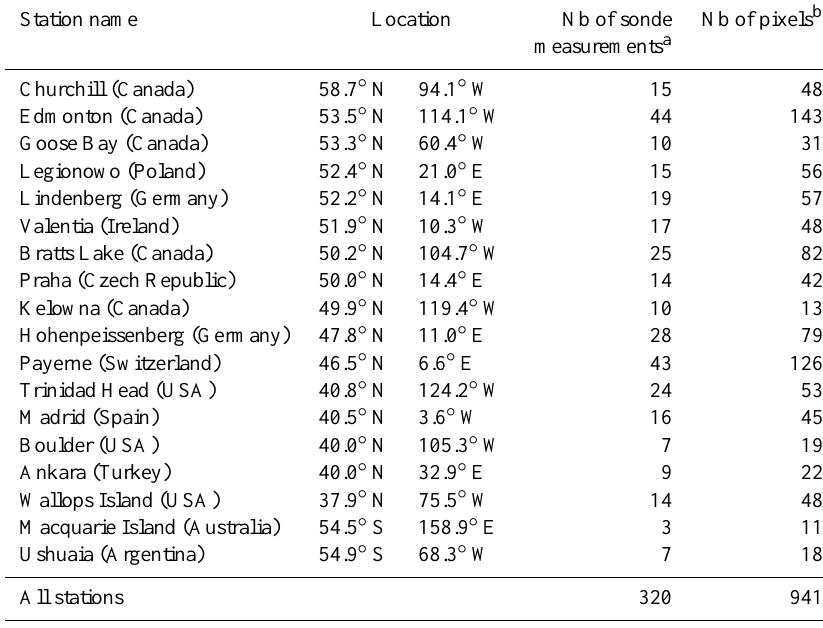
Table 2. Ozonesonde stations used for the validation in the midlatitudes. The number of available measurements used in the validation is detailed as well as the number of selected pixels of IASI.